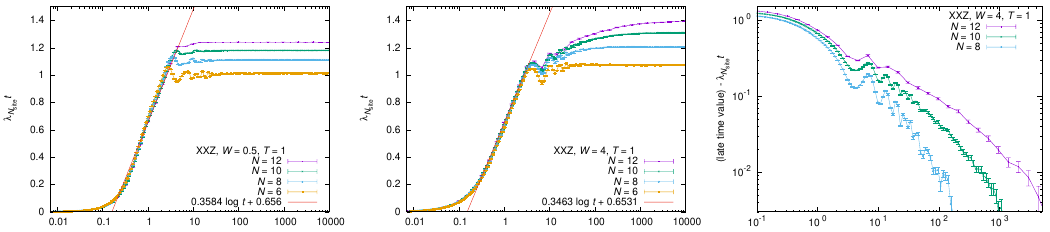
Figure 14 . [Left] XXZ model, h (cid:21) N t i , W = 0 : 5 (ergodic phase), T = 1. The growth starts as site (cid:21) N t (cid:24) 0 : 22 t (usual exponential growth), then accelerated to (cid:21) N t (cid:24) 1 : 1 t 1 : 5 , and then a power site site growth (cid:21) N t (cid:24) 0 : 36 log t is observed all the way up to the plateau. [Middle] h (cid:21) N t i , W = 4 : 0 site site (MBL phase), T = 1. The growth starts as (cid:21) N t (cid:24) 0 : 78 t (usual exponential growth), then from site t (cid:24) 0 : 3 the power growth (cid:21) N t (cid:24) 0 : 35 log t sets in, but unlike the case of W = 0 : 5, it ends at site t (cid:24) O ( N 0 ) before the plateau is reached at exponetially long times. [Right] The late-time behavior site of h (cid:21) N t i , W = 4 : 0 (MBL phase), T = 1. The deviations from the late time values are plotted site